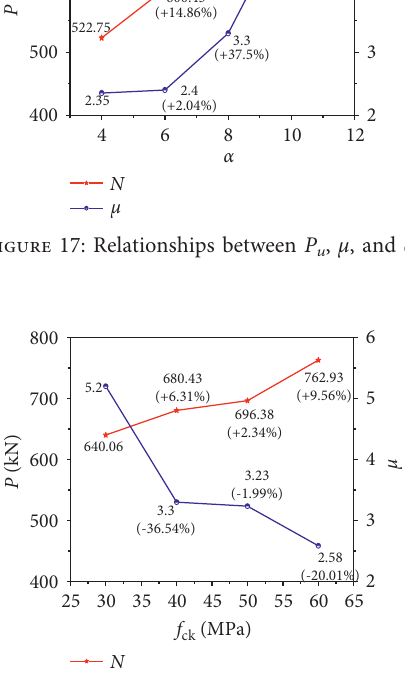
Figure 18: Relationships between P